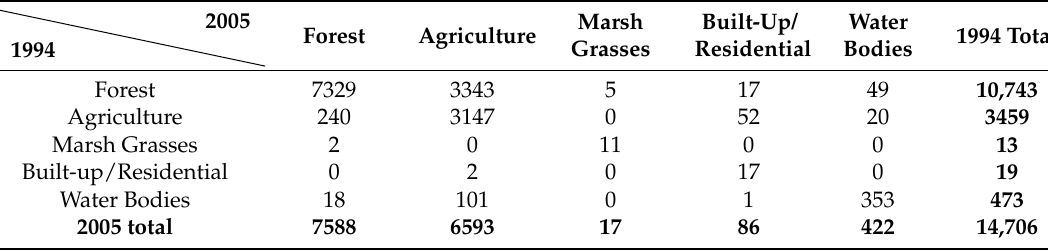
Table 5. Land cover conversion matrix for 1994–2005 (units: km 2 ).